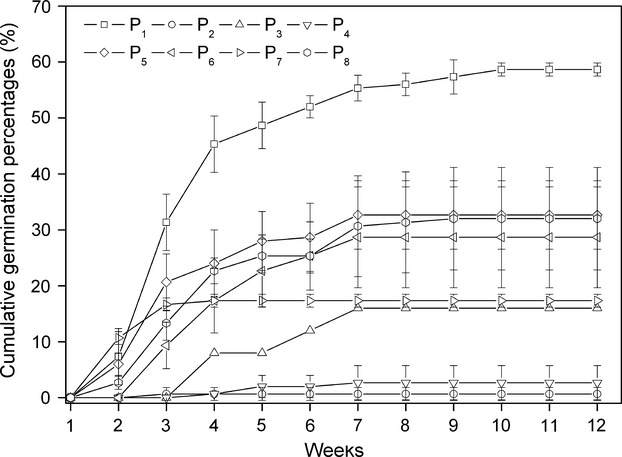
Total germination fraction (Mean ± SE) of 50 seeds of Potamogeton pectinatus incubated for 12 weeks in the climate chambers.